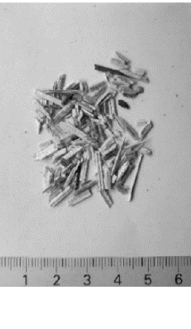
Buildings 2020 , 10 , x FOR PEER REVIEW Figure 7. Distribution of particle masses (Bialobrzeskie shive). Figure 7. Distribution of particle masses (Bialobrzeskie shive).